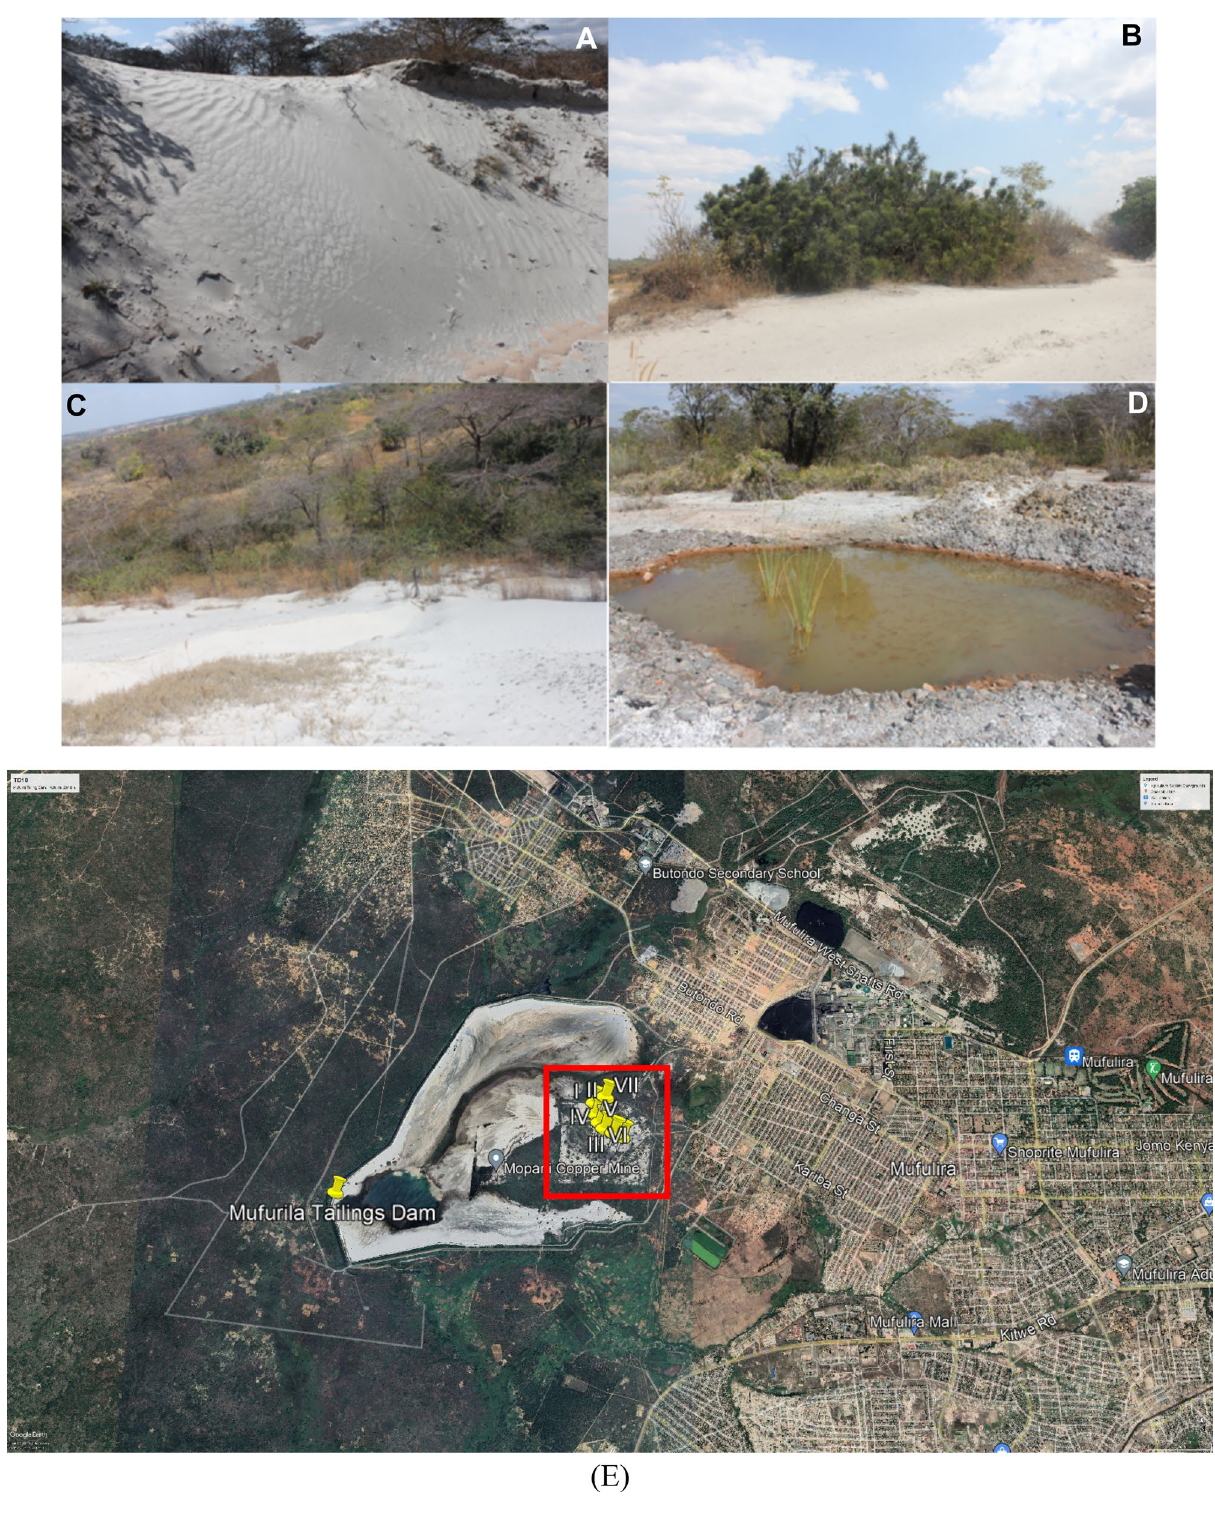
Figure 4. Mufulira TD10: ( A ) the copper tailings with some growing plants. ( B , C ) The ever-increasing plants in the tailing show the resistance capacity. ( D ) The wastewater dump formed near the tailings heaps at Mufulira TD10. Images were taken in June 2021. ( E ) An aerial photograph showing sampling points in yellow numbered I to VII at Mufulira tailing dam (TD10) location and the current area under reclamation and restoration in red square, Google Earth Satellite Image system, January